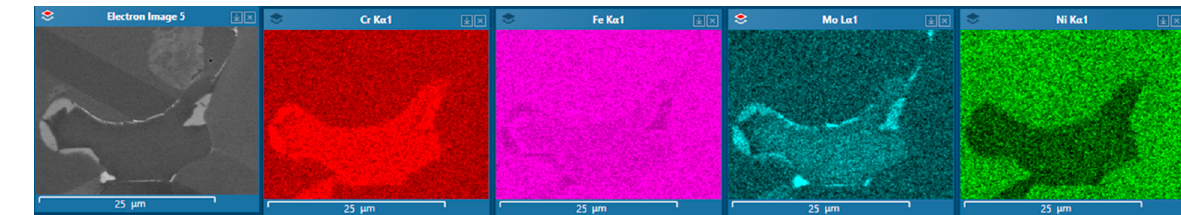
Figure 11. EDS mapping of Build 2 showing the Mo, Cr rich grain, and Mo rich layer.